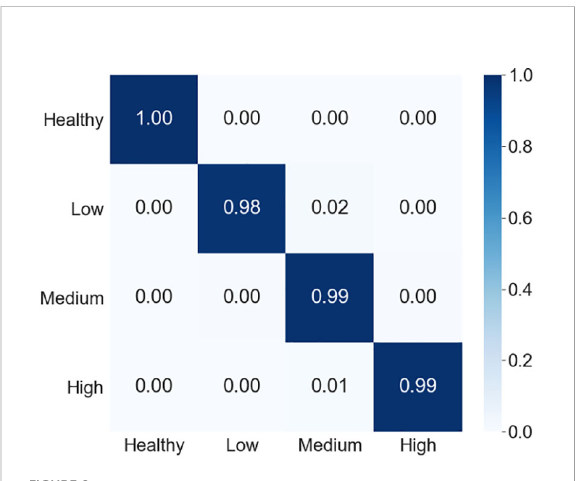
FIGURE 9 Confusion matrix of the proposed model on testing